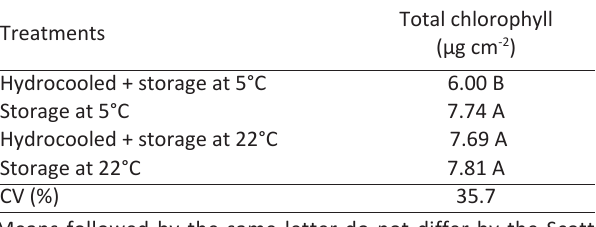
Table 2 - Influence of the hydro cooling and temperature of sto- rage on the total chlorophyll content during storage period of iceberg lettuce ‘Lucy Brown’ Total chlorophyll Treatments (µg cm -2 ) Hydrocooled + storage at 5°C 6.00 B Storage at 5°C 7.74 A Hydrocooled + storage at 22°C 7.69 A Storage at 22°C Means followed by the same letter do not differ by the Scott Knott test at 5%